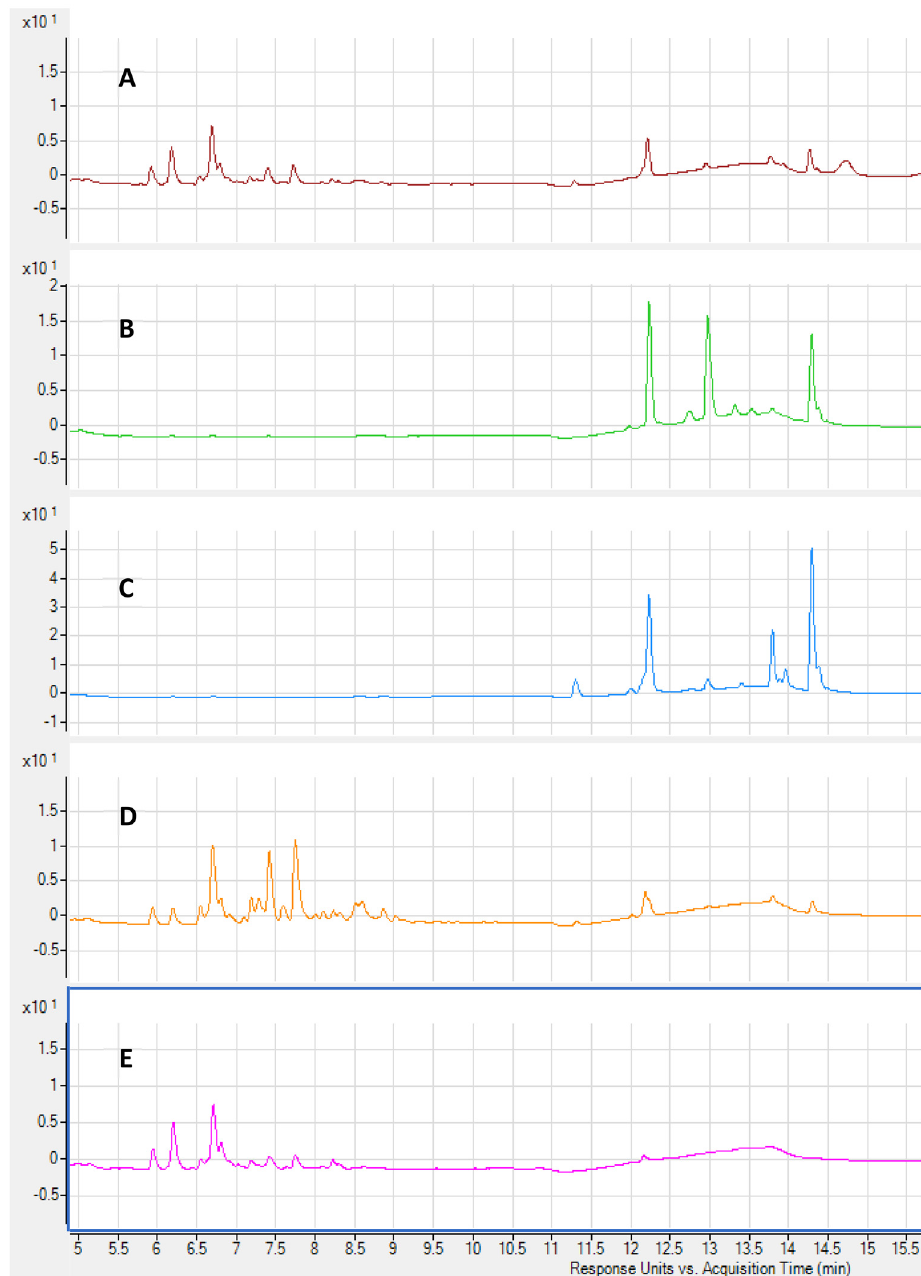
Figure 4. Reverse-phase chromatograms at 380 nm for the crude extract and fractions of E. rossii . ( A ) crude extract; ( B ) n -hexane; ( C ) dichloromethane; ( D ) ethyl acetate; and ( E ) ethanol.